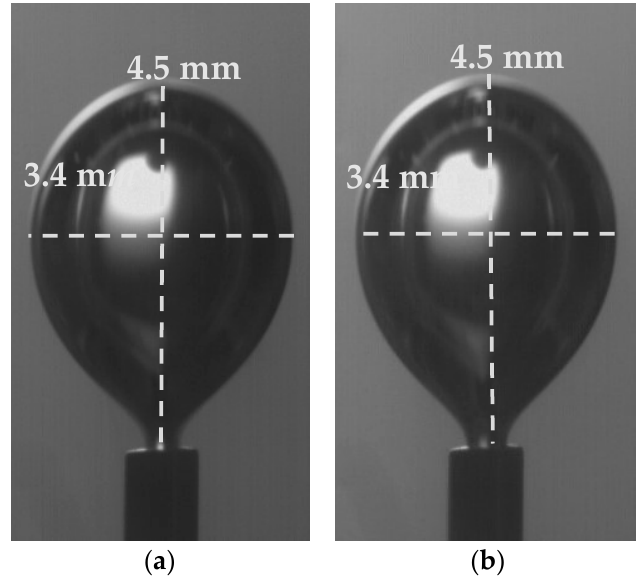
Figure 9. Bubble size during release time t 0 from tube 110 μ m for fluids: ( a ) G1n, ( b ) G1.